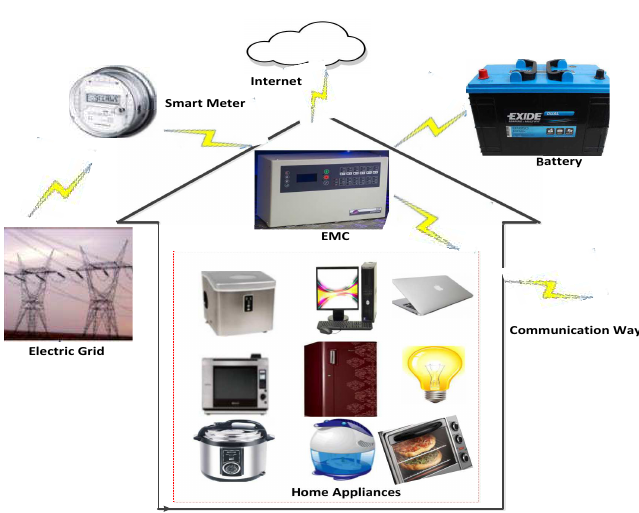
Figure 2. Proposed HEMS